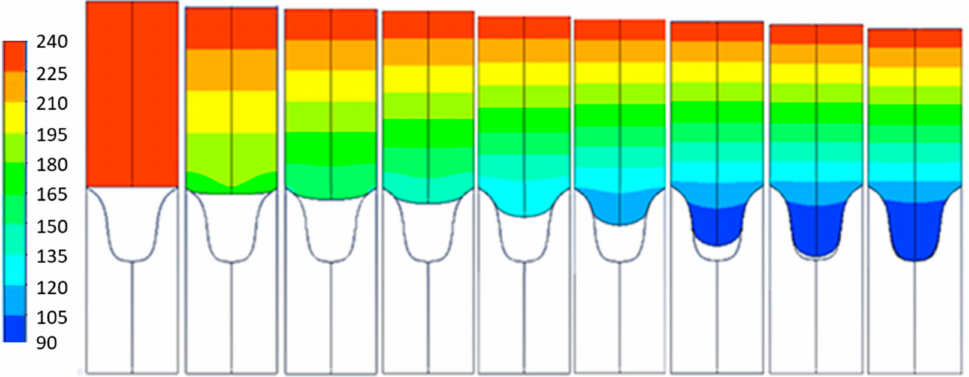
Figure 6. Evolution of Polyflow replication for T = 230 ◦ C and Tm = 90 ◦ C at different times from left to right of t = 0, 0.01, 0.05, 0.1, 0.5, 1, 5, 10, 15